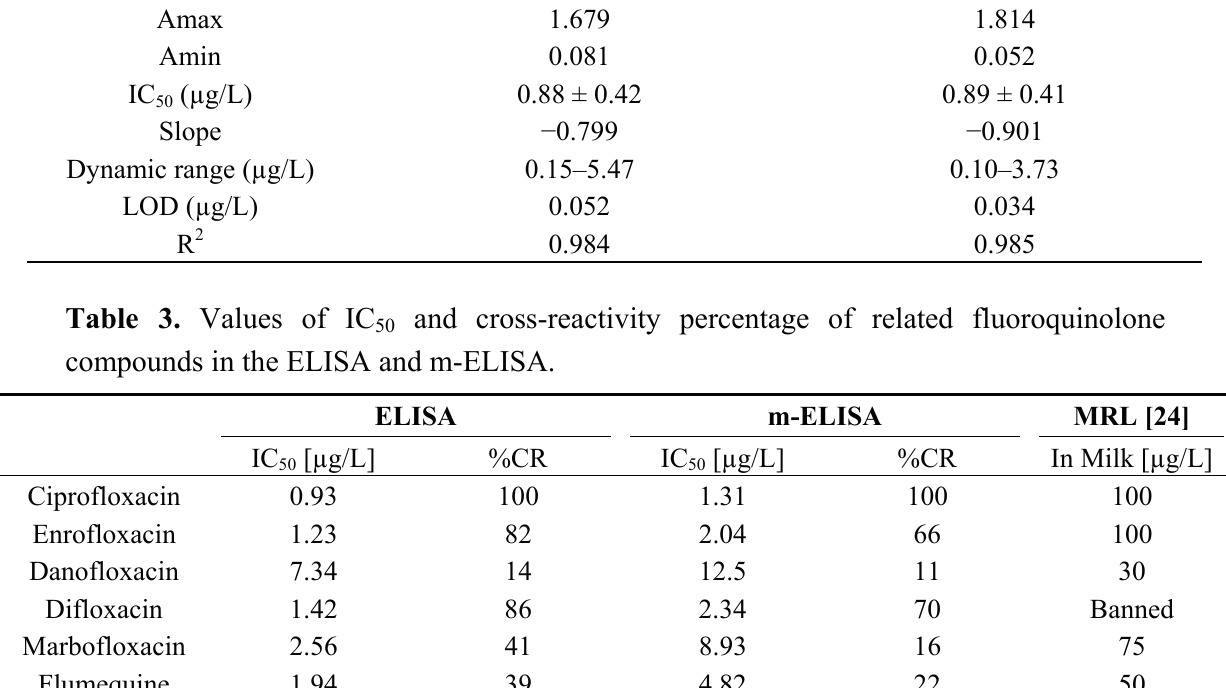
, in blue; ( b ) TE , f f